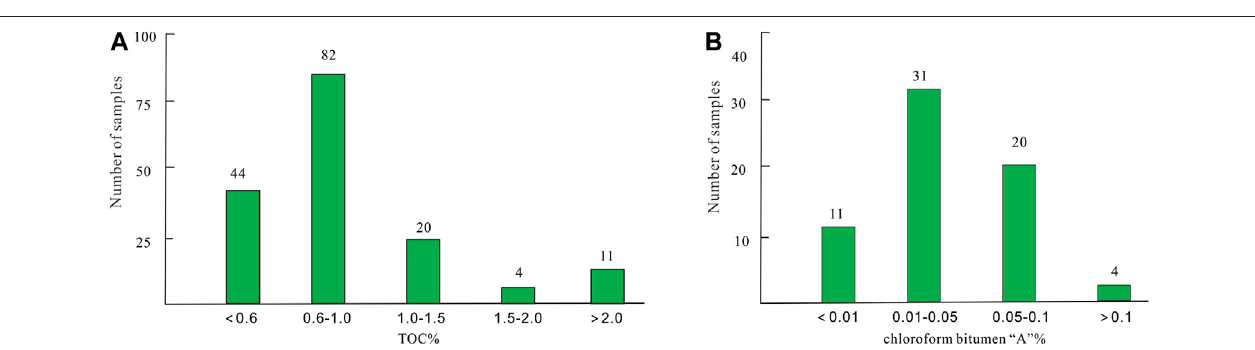
FIGURE4|(A) TOCcontentfrequencydistributionand (B) chloroformbitumen “ A ” (%)contentfrequencydistributionofsourcerockofLucaogouFormationinWell XJC